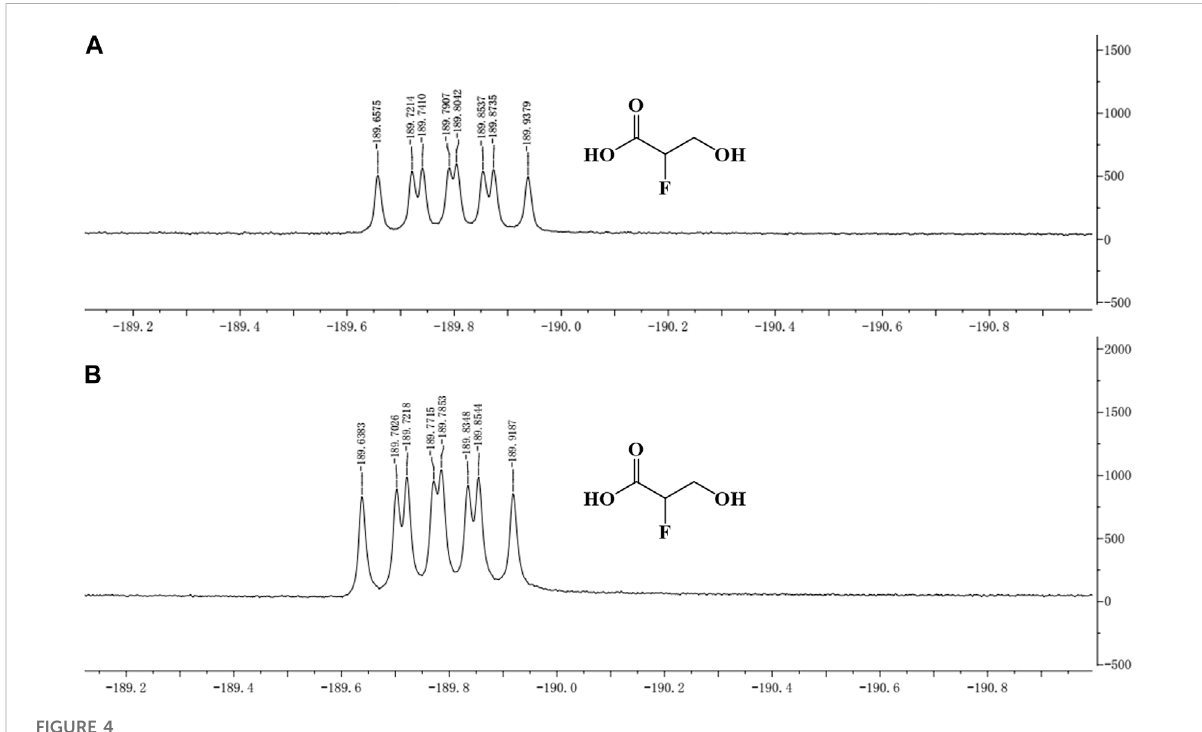
FIGURE 4 19 F-NMR of 2-F-3-HP standard and sample. (A) 19 F-NMR of the 2-F-3-HP standard; (B) 19 F-NMR of the sample.